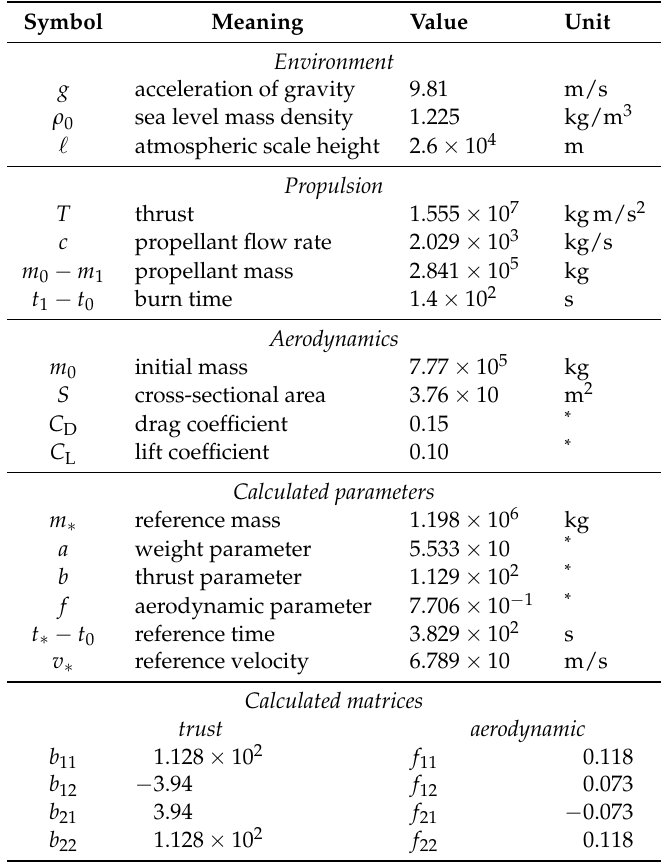
Table 1. Input data for the calculation of rocket trajectories, extended from vertical ascent (Table 2 in [21]) to a gravity turn. The matrices were calculated for α = 2 ◦ and (cid:101) = 0 (cf. text)